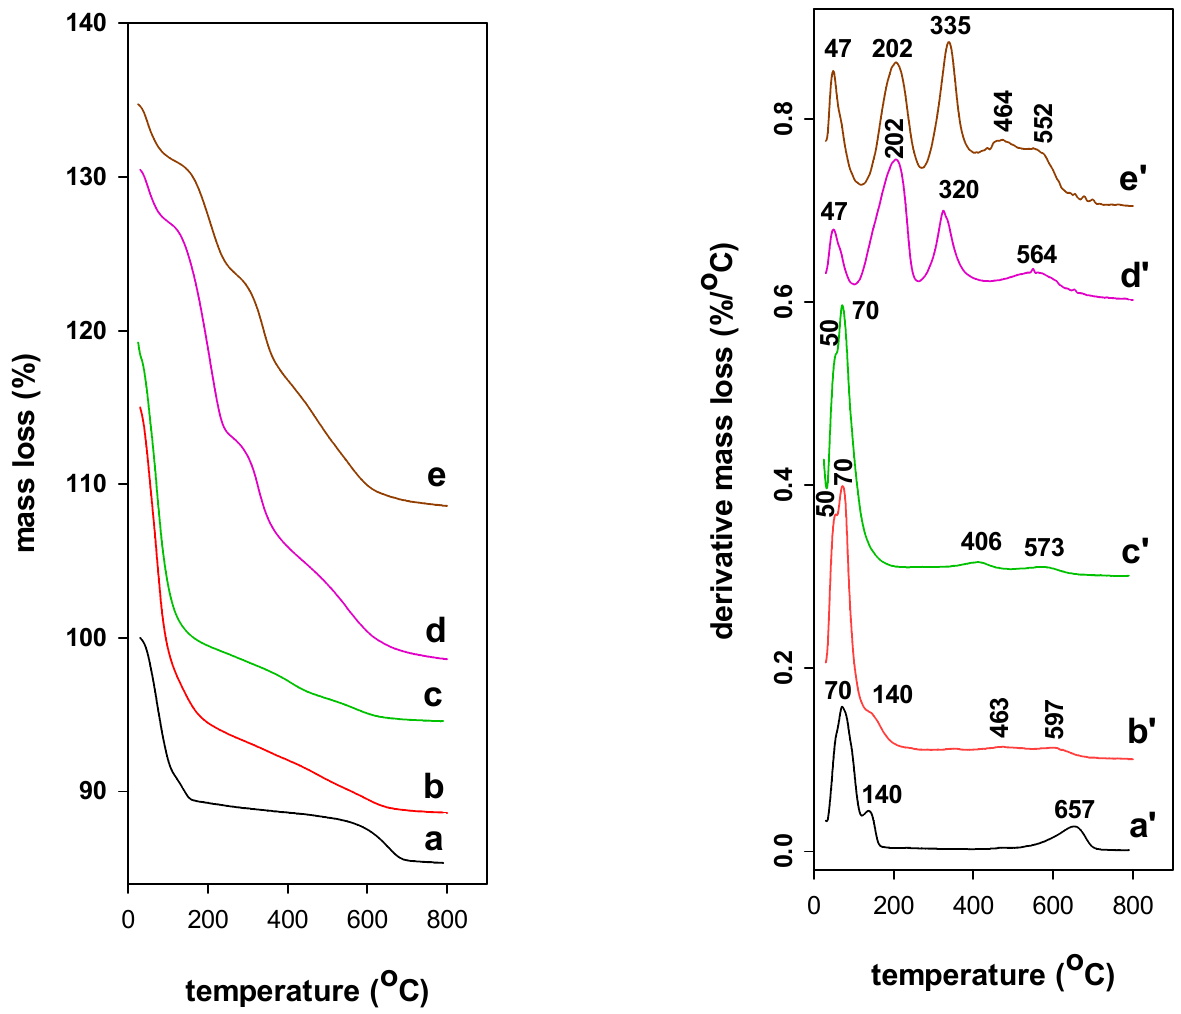
Figure 5. TGA and DTG features of ( a , a ′ ) starting Ca-Mt, ( b , b ′ ) Al-Mt, ( c , c ′ ) Zr-Mt, ( d , d ′ ) Al-PCH, and ( e , e ′ ) Z-PCH precursors.